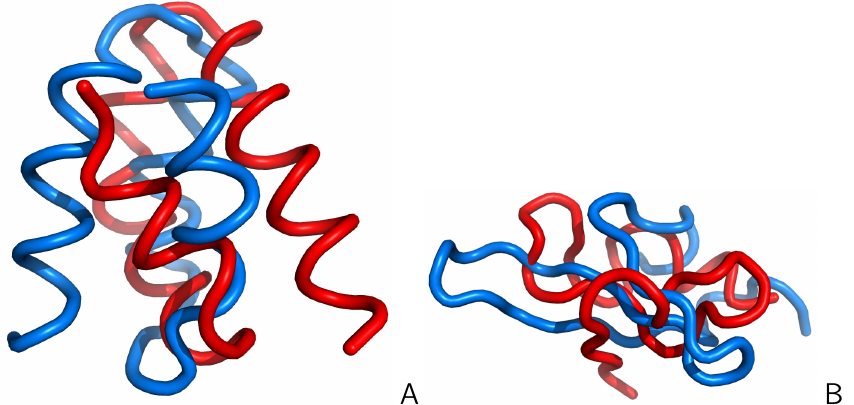
Figure 4. Superpositions of the experimental (blue) and intermediate (red) structures of ( A ) 1BDD and ( B ) 1E0L proteins. Reproduced from A. Lipska et al., J. Chem. Phys. 144, 184110 (2016), with the permission of AIP